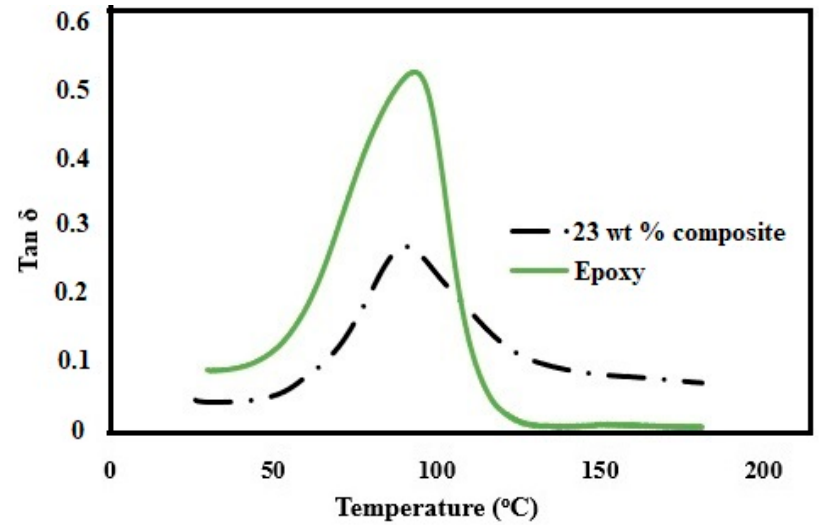
Figure 9. Temperature dependence of the tan δ for pure CNF, epoxy, and the 23 wt % composite.